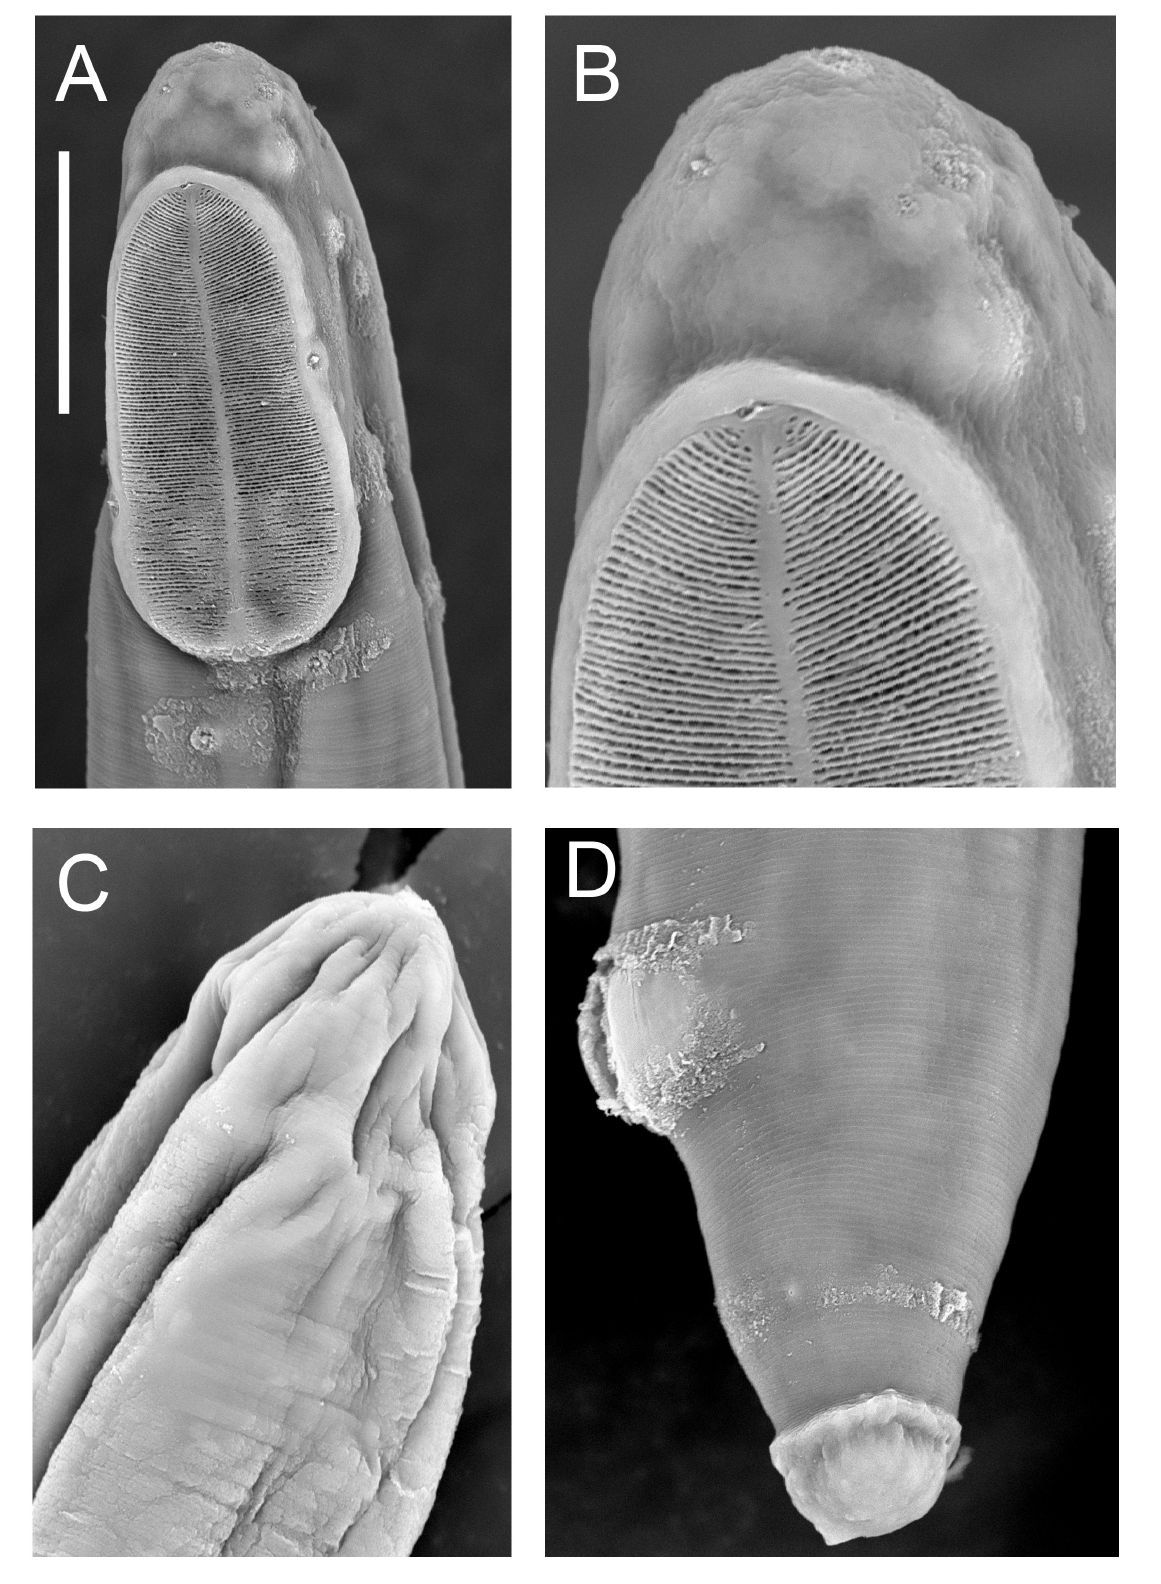
Fig. 4. Rhaptothyreus typicus Hope & Murphy, 1969. Scanning electron micrographs. A - B . Male head. C . Juvenile head. D . Male posterior body region. Scale bar: A = 20 µm, B = 8 µm, C = 12 µm, D = 16